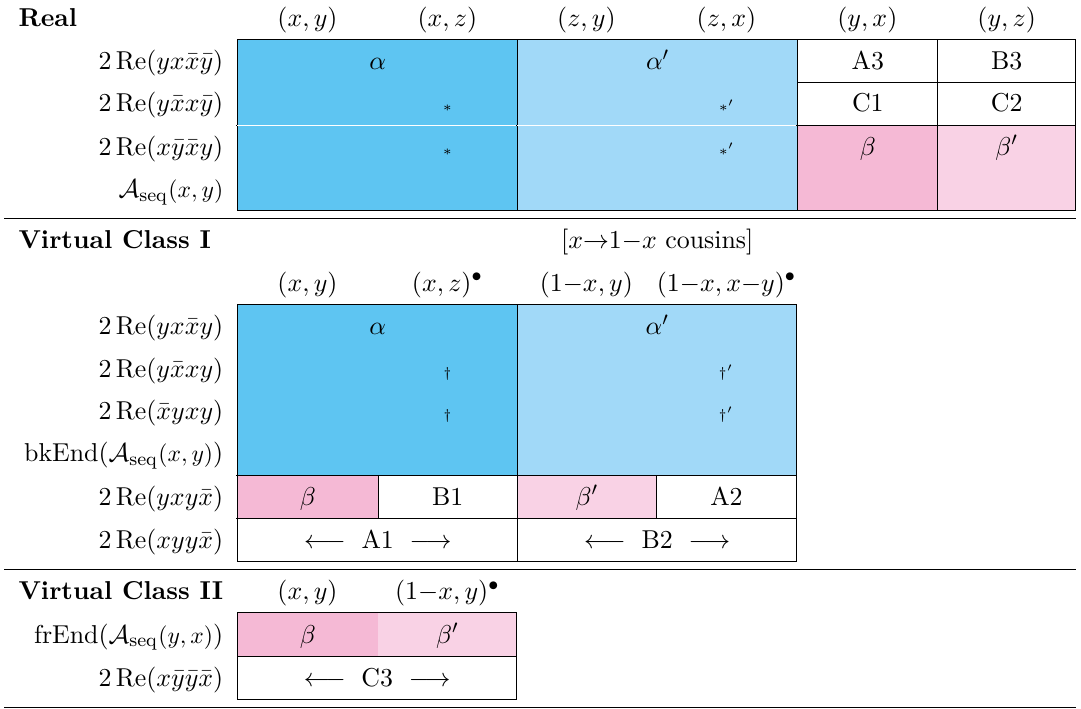
Table 1 . The shaded regions (labeled α , α 0 , β , and β 0 ) depict groups of cancellations among IR single and double logs from real ( g → ggg ) and virtual (next-to-leading-order g → gg ) processes as y → 0 . The unshaded entries do not cancel and are labeled according to figure 6. The fist column gives the names of diagrams, in the convention of ref. [20]. For the real diagrams, each row covers six distinct diagrams given by permutations of the daughters ( x, y, z ) of the g → ggg process, where the column headers denote what ( x, y ) is permuted into relative to the diagram name in the first column, and where z ≡ 1 − x − y . A column header ( ξ, χ ) means to replace ( x, y ) → ( ξ, χ ) in the diagram listed in the first column. Column headers with bullet superscripts ( • ) do not represent different diagrams but instead represent a different labeling of the internal lines of the un-bulleted header to the left, corresponding to a different soft limit ( y → 0 ) of that diagram. For each Class I virtual diagram, another distinct diagram can be generated by substituting x → 1 − x (see ref. [20]), as also indicated by the column headers ( ξ, χ ) . A seq represents only one of the two large- N c color routings of “sequential” diagrams (see ref. [15] for details). bkEnd and frEnd refer to back-end and front-end transformations, as described in refs. [18, 20]. The notations ∗ , ∗ 0 , † and † 0 on certain pairs of table entries are explained in the text. The labels A1, A2, . . . , C3 above are shorthand for the corresponding diagrams of figure 6 plus their complex conjugates. The meaning of the double-sized boxes for A1, B2, and C3 is explained in appendix